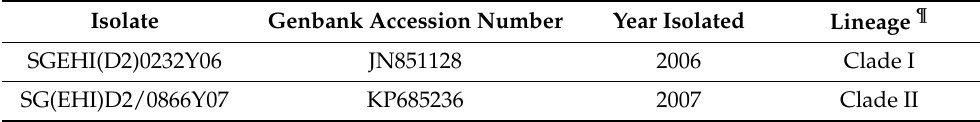
Table 1. Details of DENV-2 isolates used in the